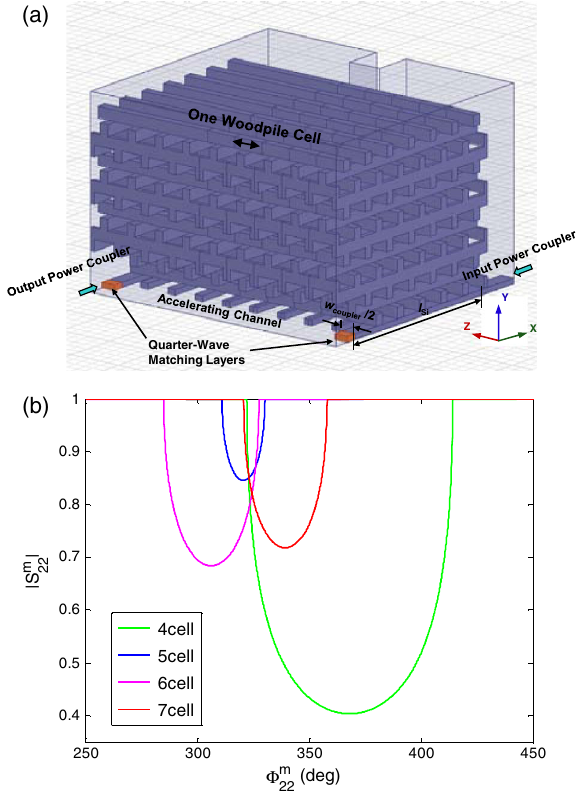
FIG. 5. (a) TE-to-TM mode coupler layout for a 7-cell wood- pile accelerating waveguide, and (b) its multiple-cell simulation results to determine the required S 22 m for traveling-wave